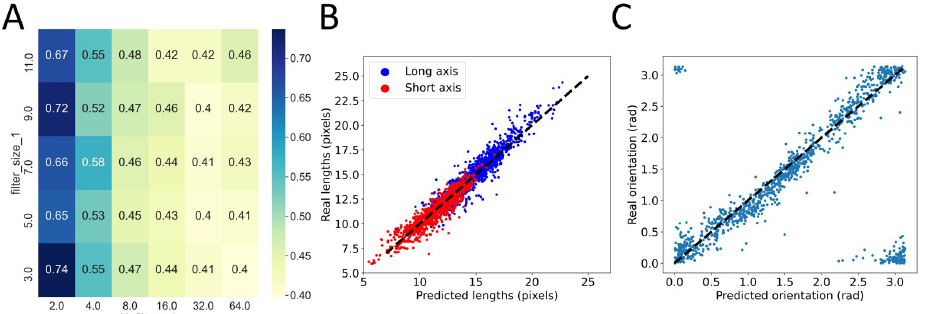
Fig 4. Grid search on 1-conv models. A: the MAE averaged over 5 folds is shown both in color and numbers as a function of the number of filters in the convolutional layer (N_filters_1) and size of these filters (filter_size_1). B: comparison between ground truth and model predictions for the optimal 1-conv model after retraining. Long axis, in blue, and short axis, in red. C: similar comparison for orientation after inverse transformation from cosine and sine. In B and C, black dashed lines are a guide for the eye representing identity.